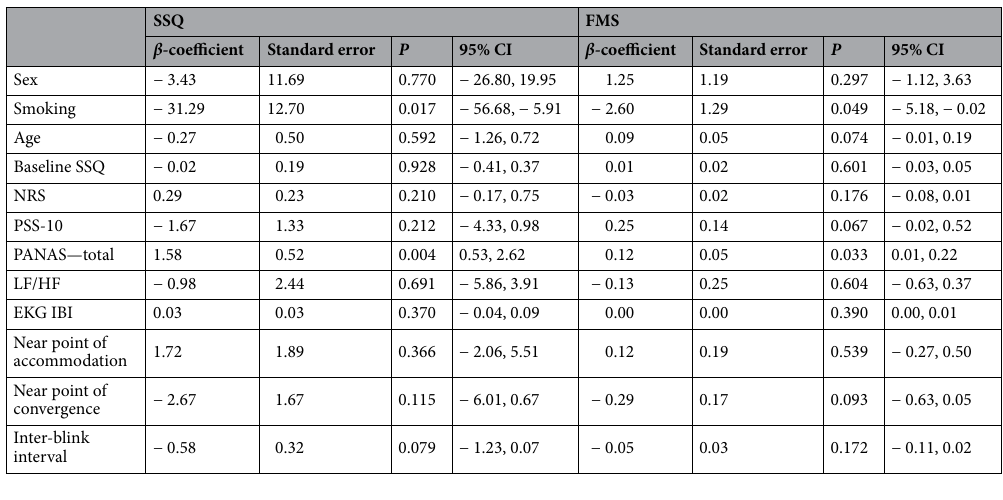
Table 4. Multivariable linear regression analysis. Explanatory variables with a p-value below 0.10 in correlation analyses were included in multivariate linear regression analyses. SSQ Simulator Sickness Questionnaire, FMS Fast Motion sickness Scale, CI confidence interval, NRS Numeric Rating Scale, PSS- 10 Perceived Stress Scale, PANAS Positive and Negative Affect Schedule, LF low frequency band, HF high frequency band, IBI inter-beat